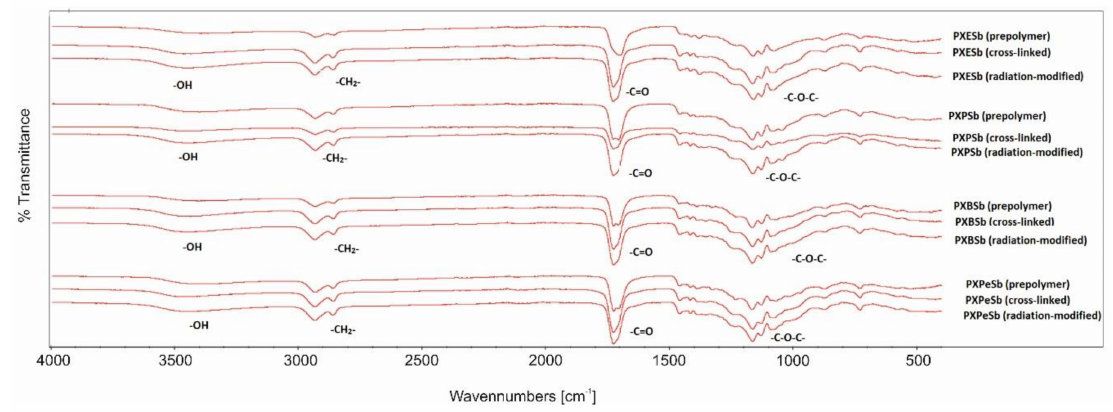
Figure 6. FTIR spectra of PXESb, PXPSb, PXBSb, PXPeSb prepolymers, cross-linked polymers, and radiation-modified polymers.